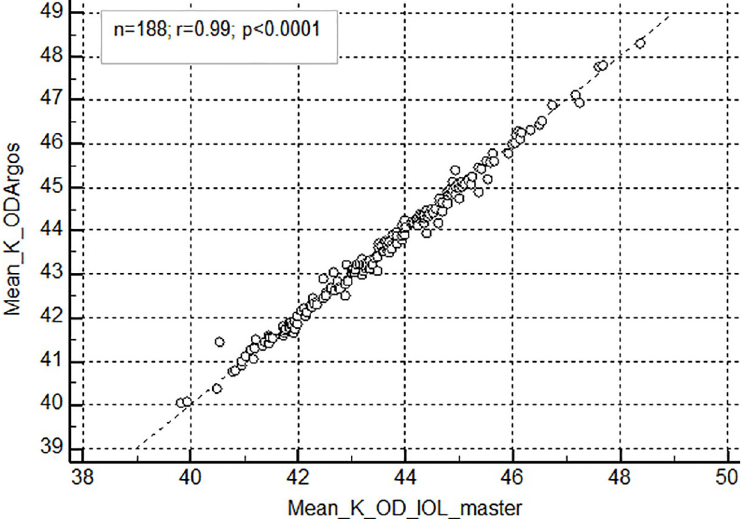
Fig 3. Correlation of Mean Corneal curvature (in Dioptres) between Argos and IOL master. K- Corneal curvature in Dioptres; OD–Right